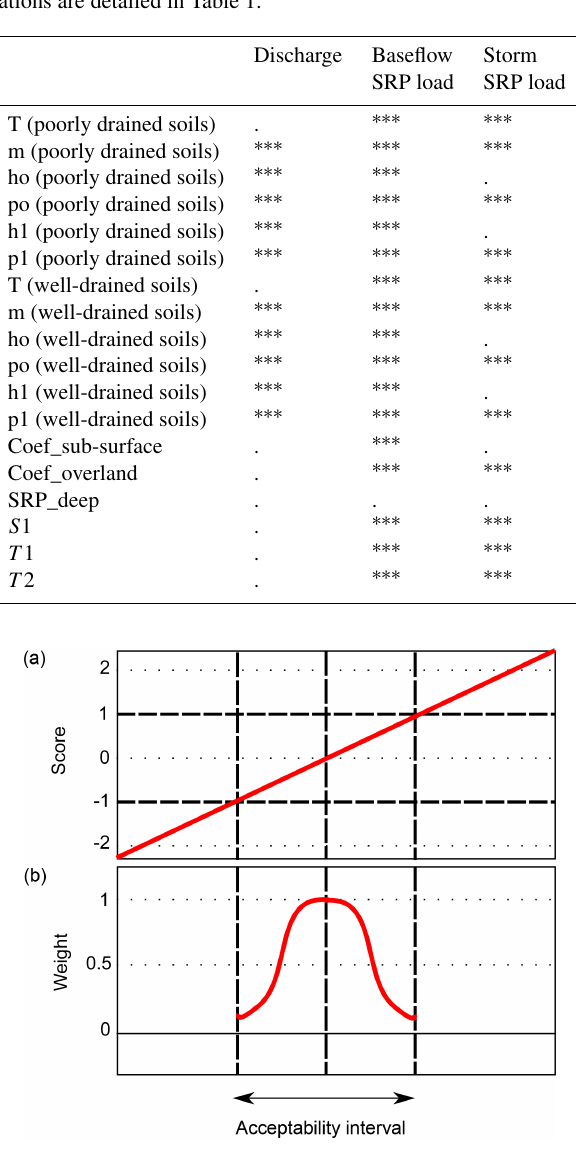
Figure 6. Normalized scores (a) and weighting function (b) .